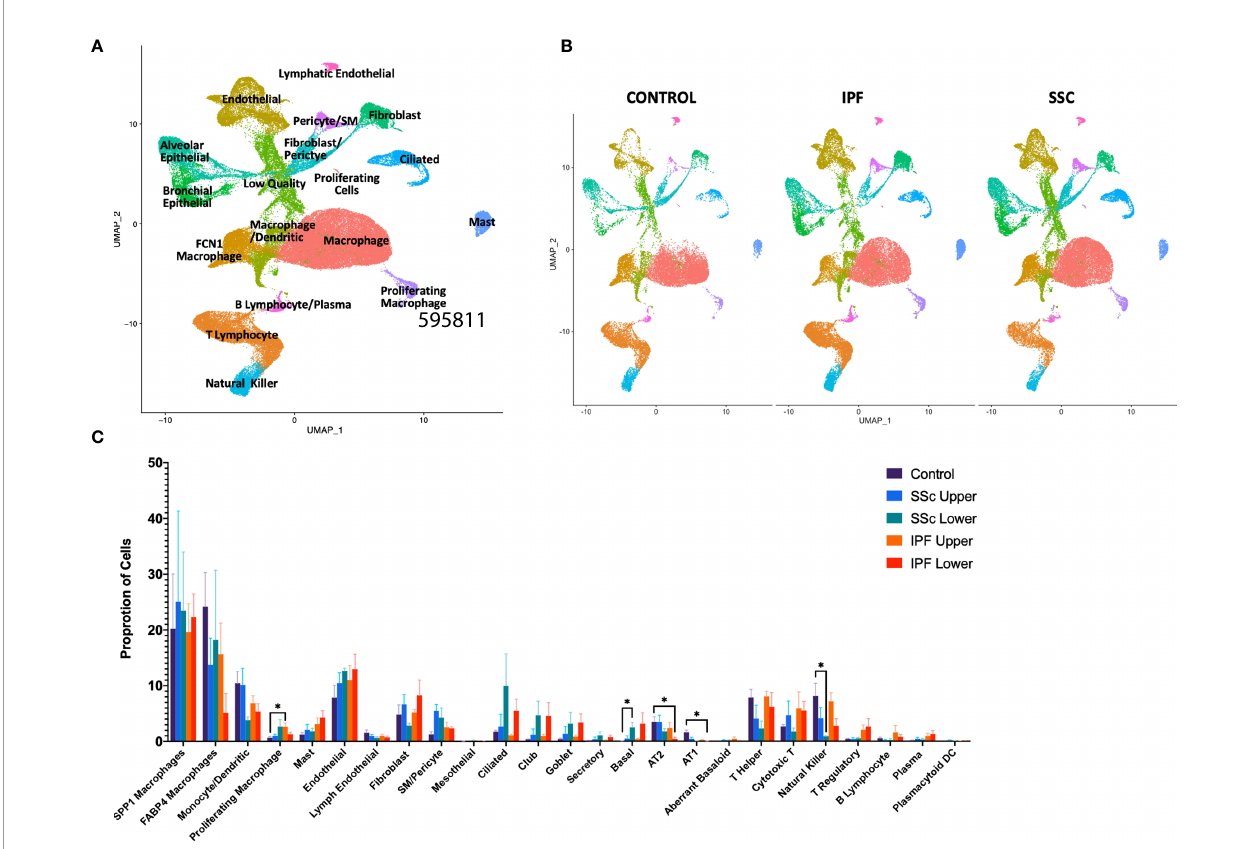
FIGURE 1 | ScRNA-seq analysis of 8 IPF, 8 SSc-ILD, and 5 organ donor control lung samples. (A) UMAP plot of all 21 integrated samples, identi fi ed by cell type. (B) UMAP plots of all samples, divided by disease status. (C) Mean percentage of total cells comprised of each cell type, comparing, control, upper lobe IPF, lower lobe IPF, upper lobe SSc-ILD, and lower lobe SSc-ILD. Bars represent the mean percentage of total cells, with error bars representing the standard error of the mean. *=p-value<0.05. scRNA-seq, single-cell RNA-sequencing; IPF, idiopathic pulmonary fi brosis; SSc-ILD, systemic sclerosis-associated interstitial lung disease; UMAP, uniform manifold approximation and